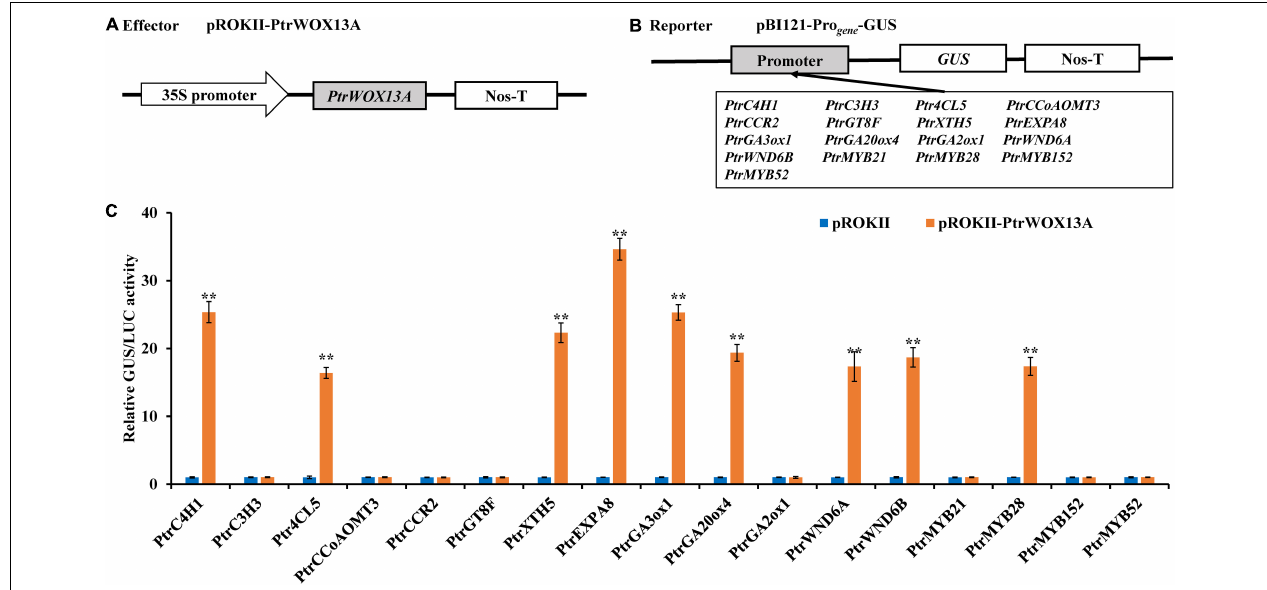
FIGURE 7 | Activation of the promoters of poplar transcription factors and secondary cell wall biosynthesis pathway genes by PtrWOX13A . (A,B) Diagrams of the effector and the reporter constructs. (C) The expression of the GUS under the control of those promoters that were activated by PtrWOX13A . GUS activity in tobacco leaves transfected with pROKII empty vector, reporter vector, and 35S-LUC-pGreenII 8000 vector was used as a control and was set to 1. GUS activity for each promoter tested is expressed as the ratio of GUS/LUC obtained with the effector pROKII-PtrWOX13A to GUS/LUC obtained with the control effector pROKII empty vector. Error bars represent the standard deviation of three biological replicates. Asterisks indicate levels of significance of differential expression (Dunnett’s test; ** p < 0.01, highly significant). Those genes include lignin biosynthesis genes ( PtrC4H1 , PtrC3H3 , Ptr4CL5 , PtrCCoAOMT3 , and PtrCCR2 ), hemicellulose biosynthesis genes ( PtrGT8F ), fiber cell elongation genes ( PtrXTH5 and PtrEXPA8 ), GA biosynthesis genes ( PtrGA20ox4 , PtrGA3ox1 , and PtrGA2ox1 ), and TFs ( PtrWND6A , PtrWND6B , PtrMYB21 , PtrMYB28 , PtrMYB152 , and PtrMYB52